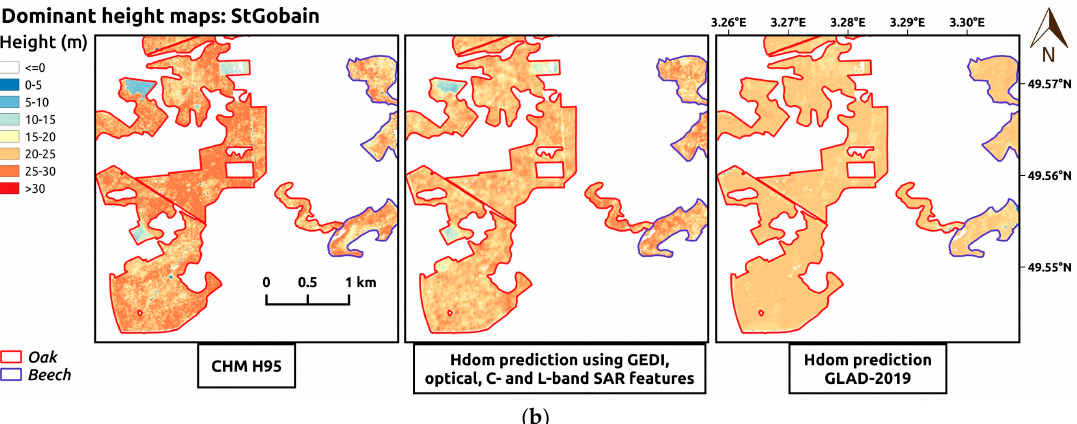
Figure 12. Local examples of Hdom maps of Orleans (( a ), top) and StGobain (( b ), bottom). Left maps: CHM-H95 computed at 10 m resolution; centre: prediction maps using the processing chain and the GEDI RH95% as reference for model learning; right: GLAD-2019 maps.